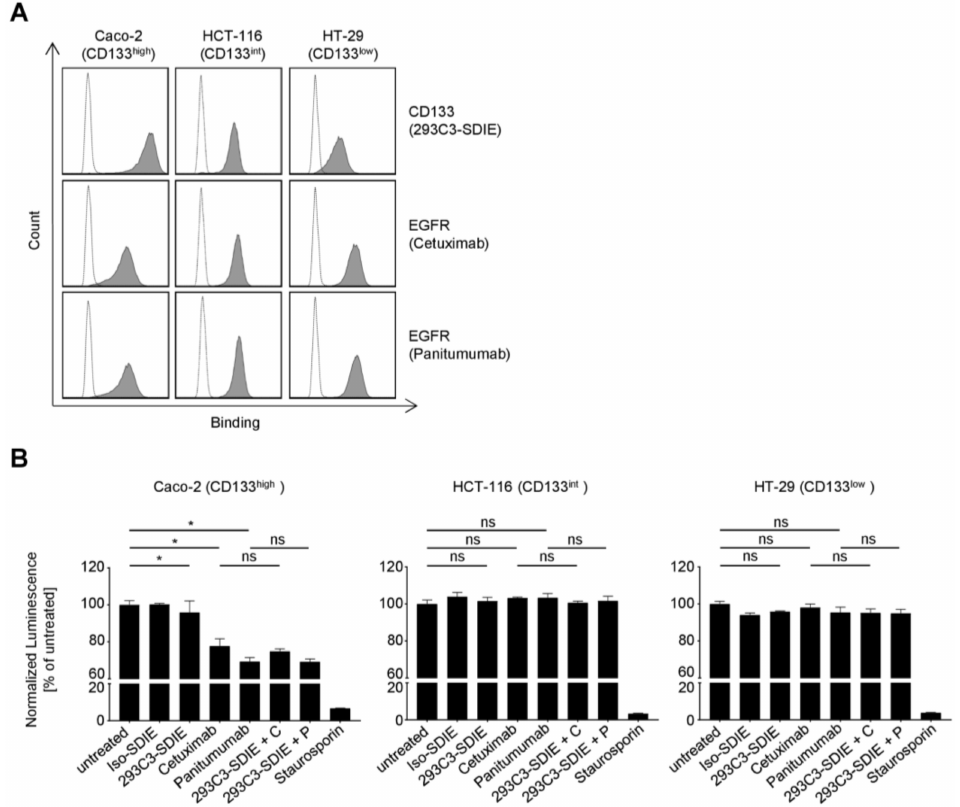
Figure 3. Direct e ff ects of 293C3-SDIE on colorectal cancer (CRC) cell viability. ( A ) CD133 and epidermal growth factor receptor (EGFR) expression on CRC cell lines were comparatively analyzed by flow cytometry using 293C3-SDIE, cetuximab and panitumumab and their respective isotype controls (all at 1 µ g / mL) followed by an anti-human phycoerythrin (PE) conjugate. Shaded peaks: specific mAbs; open peaks: isotype controls. ( B ) Caco-2 (left), HCT-116 (middle), and HT-29 (right) cells were incubated with 1 µ g / mL of the indicated mAbs for three days. ATP levels were then determined by CellTiterGlo assays. Representative data of one experiment from a total of at least two with similar results are shown. C: cetuximab; int: intermediate; ns: not significant; P: panitumumab; *: significant ( p -value <